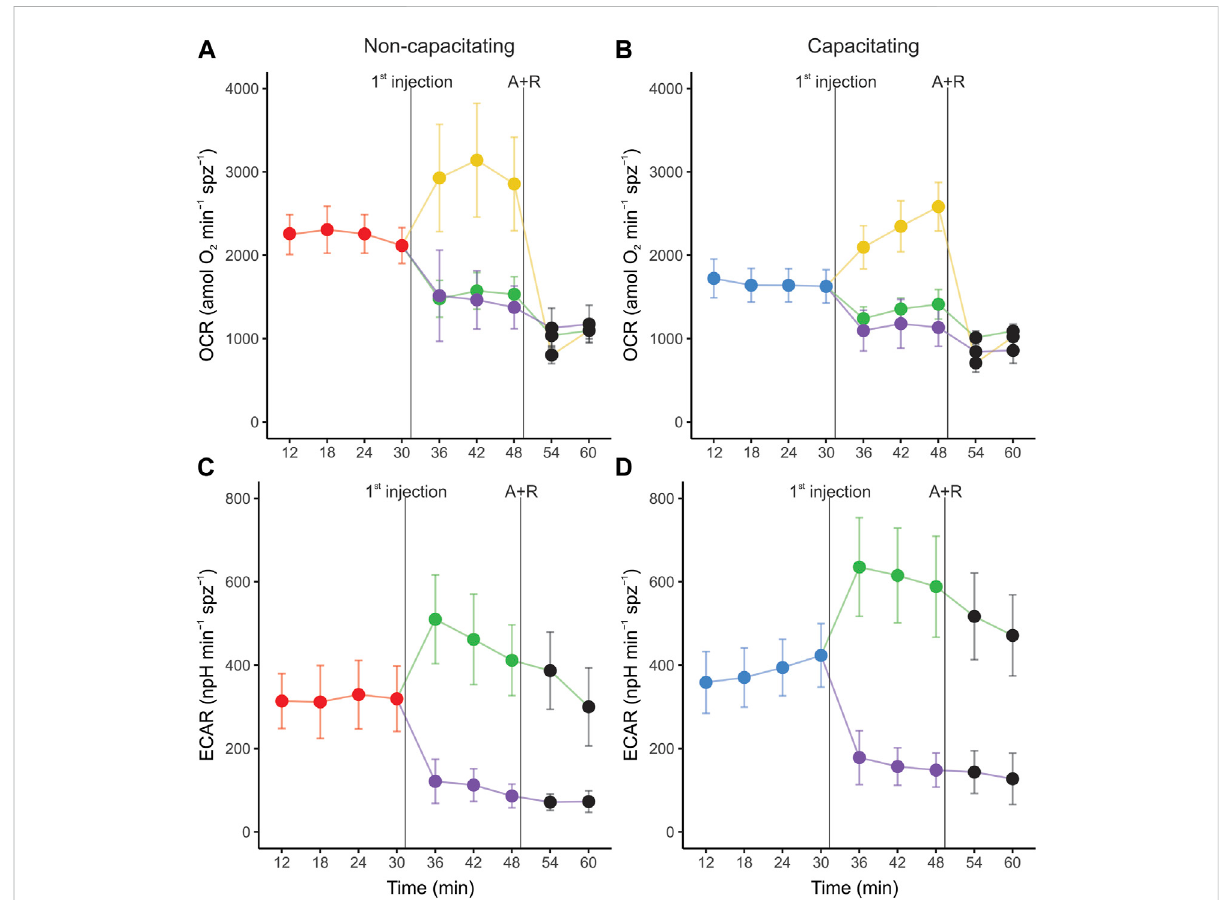
FIGURE 2 Real-time measurements of oxygen consumption rate (OCR) (A,C) and extracellular acidi fi cation rate (ECAR) (B,D) in mouse sperm before and after treatment with metabolic modulators. Sperm were incubated for 1 h in non-capacitating (A,C) and capacitating (B,D) conditions prior to extracellular fl ux analysis. Values have been normalized by sperm numbers inside each well. Symbols and whiskers correspond to means ± standard error. Time = 0 was de fi ned as the start of the fi rst measurement cycle; measurement cycles 3 to 11 are reported. The line labeled as “ 1st injection ” marks the addition of either 5 µM oligomycin, 1 µM FCCP, or 50 mM 2DOG; the line labeled “ A + R ” marks the addition of 1 µM antimycin A+1